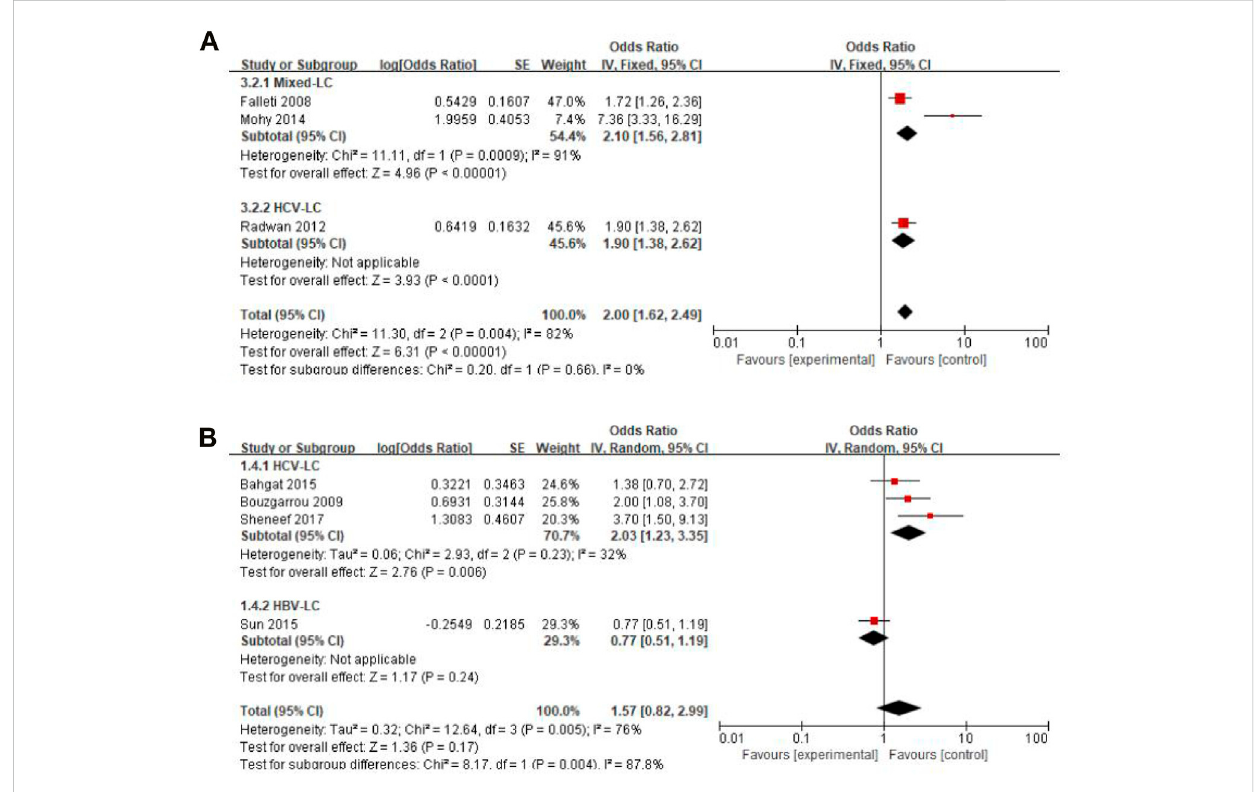
FIGURE 3 Forest plot of subgroup analyses by different etiologies of liver cirrhosis. (A) TGF- β 1 -509 T vs. C; (B) IFN- γ +874 T vs.